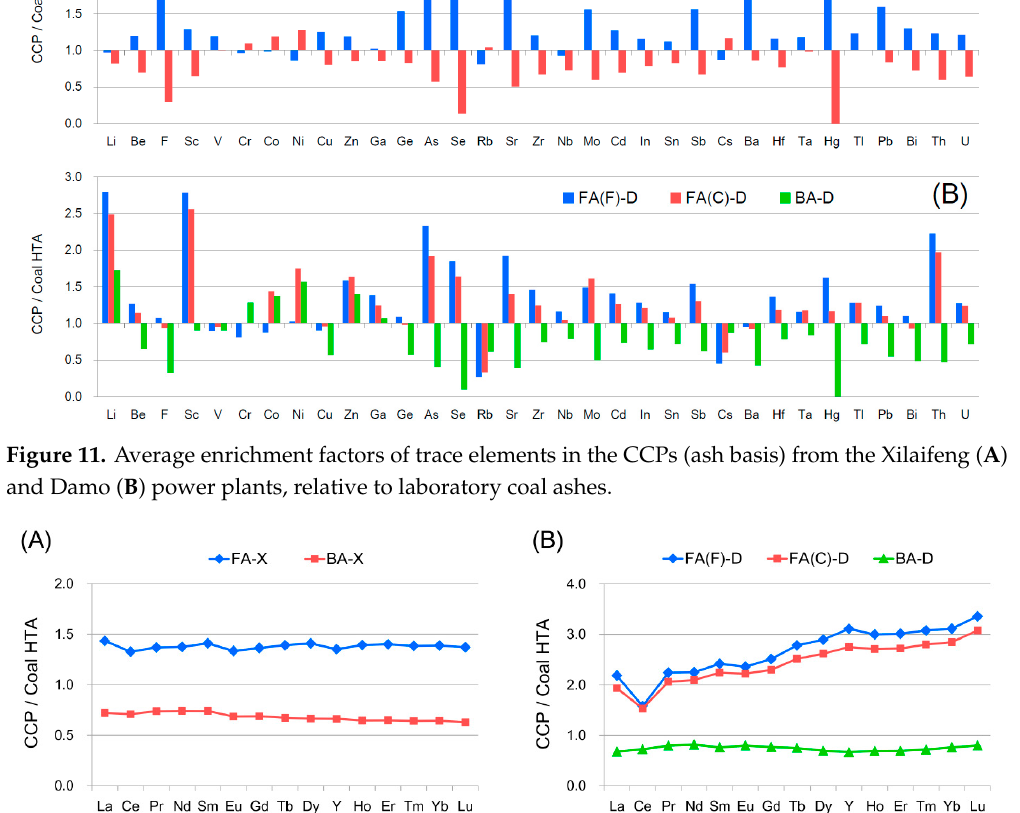
Figure 11. Average enrichment factors of trace elements in the CCPs (ash basis) from the Xilaifeng ( A ) and Damo ( B ) power plants, relative to laboratory coal ashes.